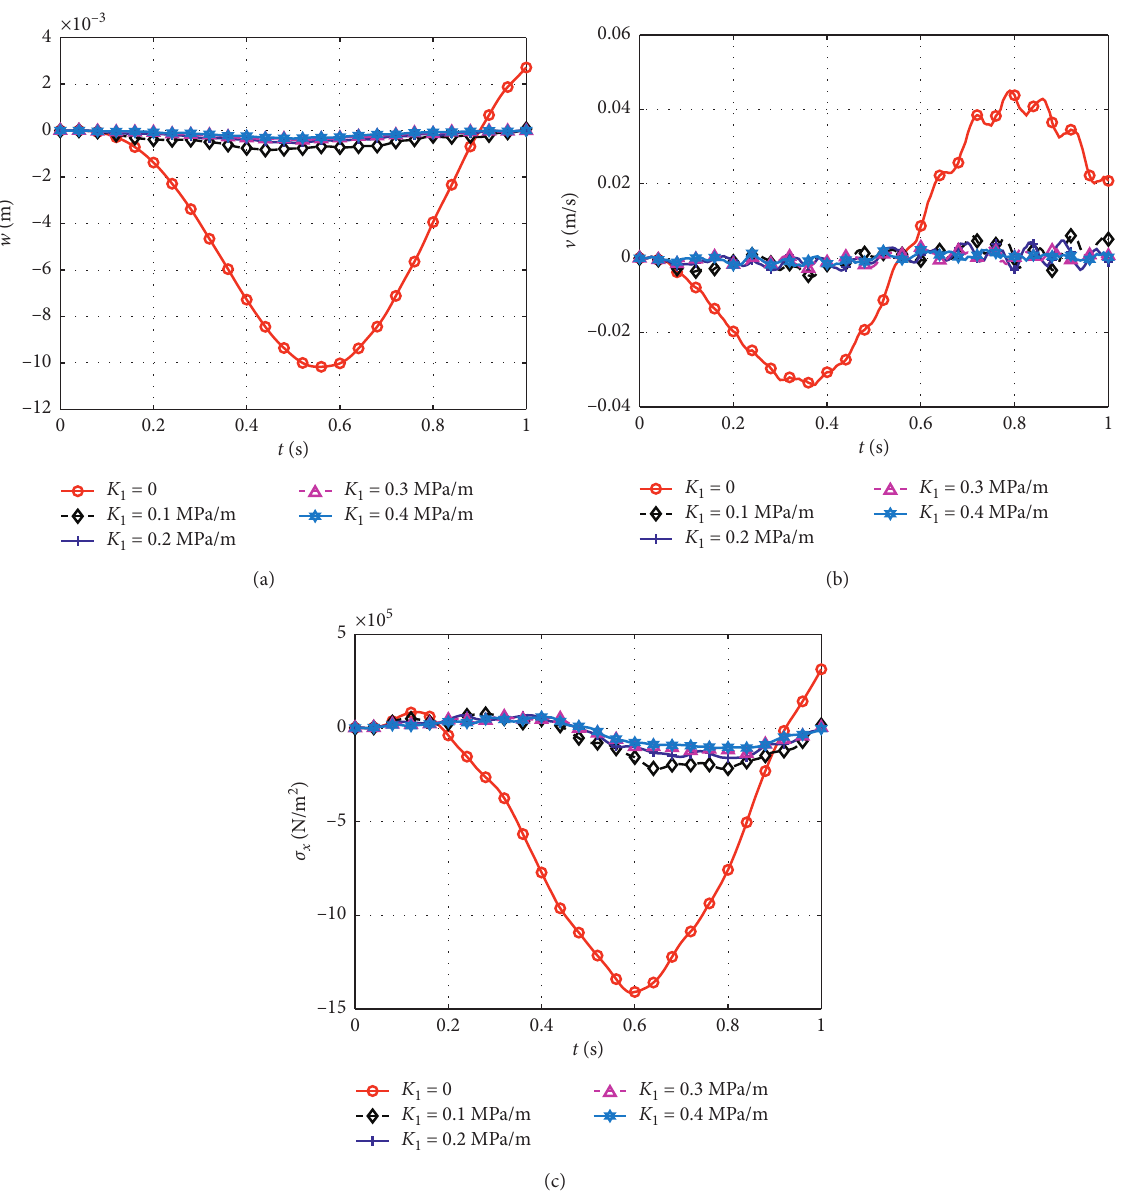
w 1 (MPa/m). (a) Deflection